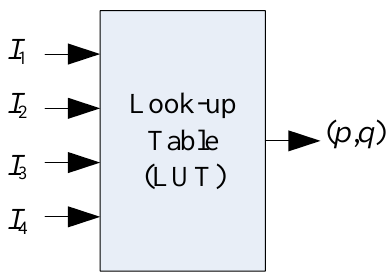
Figure 4. Conceptual diagram of the look-up table.